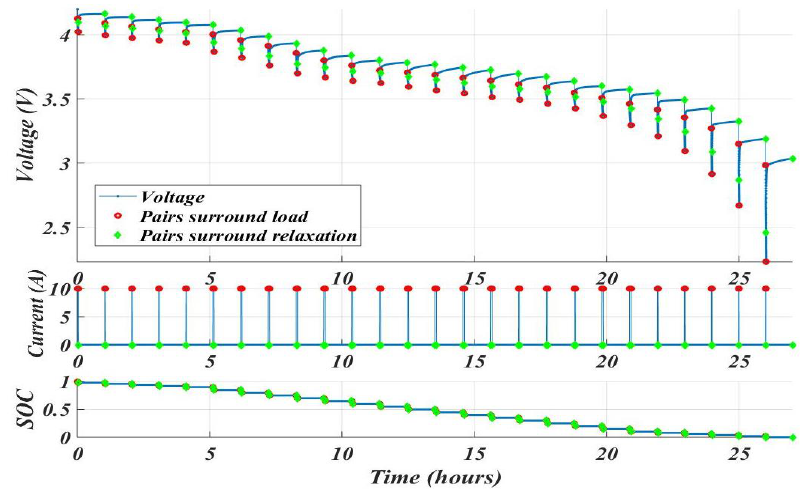
Figure 8. Voltage response, current and the SOC range of Li polymer cell.